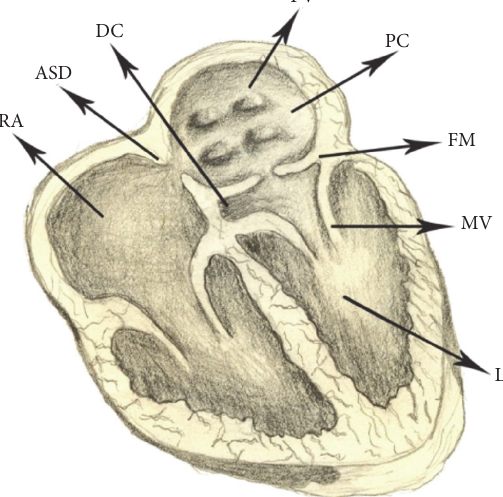
Figure 4: The classic form of cor triatriatum, demonstrating a fibromuscular membrane in the left atrium separating the proximal chamber from the distal chamber containing the mitral valve and left ventricular inflow. Of note, this drawing contains an atrial septal defect which is not required to be present for the diagnosis of cor triatriatum. LV: left ventricle, RV: right ventricle, LA: left atrium, RA: right atrium, MV: mitral valve, ASD: atrial septal defect, PV: pulmonary vein, PC: proximal chamber, and FM: fibromuscular membrane. (J Tehran Heart Cent. 2010 Summer; 5(3): 153–155. Published online 2010 Aug 31. © Copyright Policy: open-access,